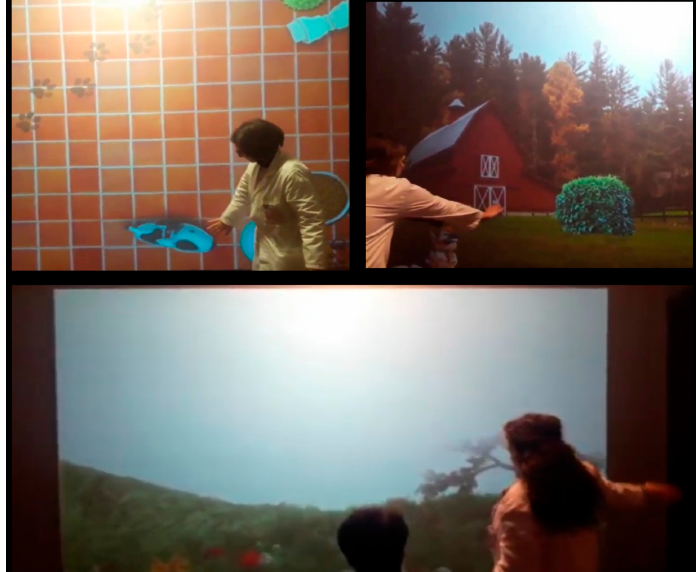
Figure 1. The Bts-Nirvana System. The therapist chooses the different scenarios according to the patient’s disability and needs; the patient may interact with the semi-immersive VR by standing or sitting (e.g., in a wheelchair, like our minimally conscious state (MCS) patient) in front of the interactive screen.